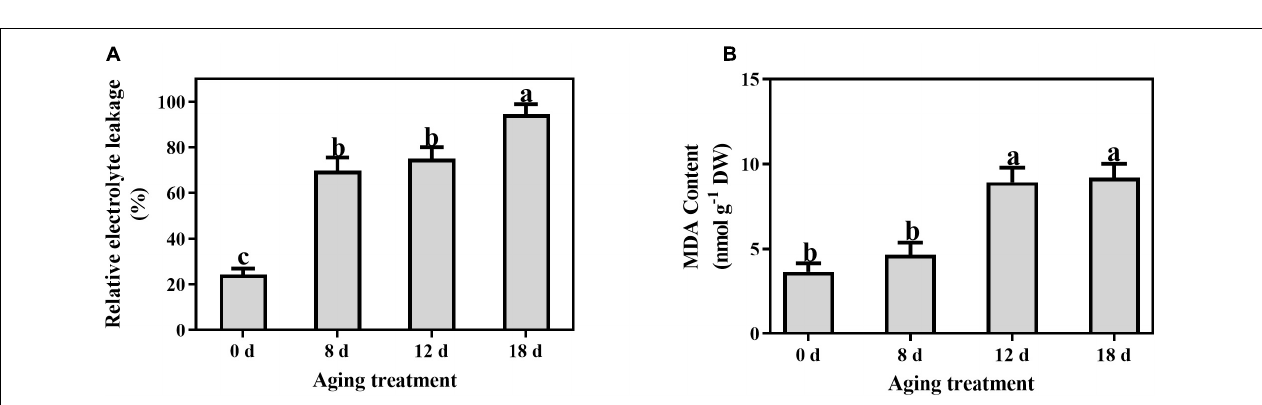
phospholipid species contents during seed aging ( Figure 5D